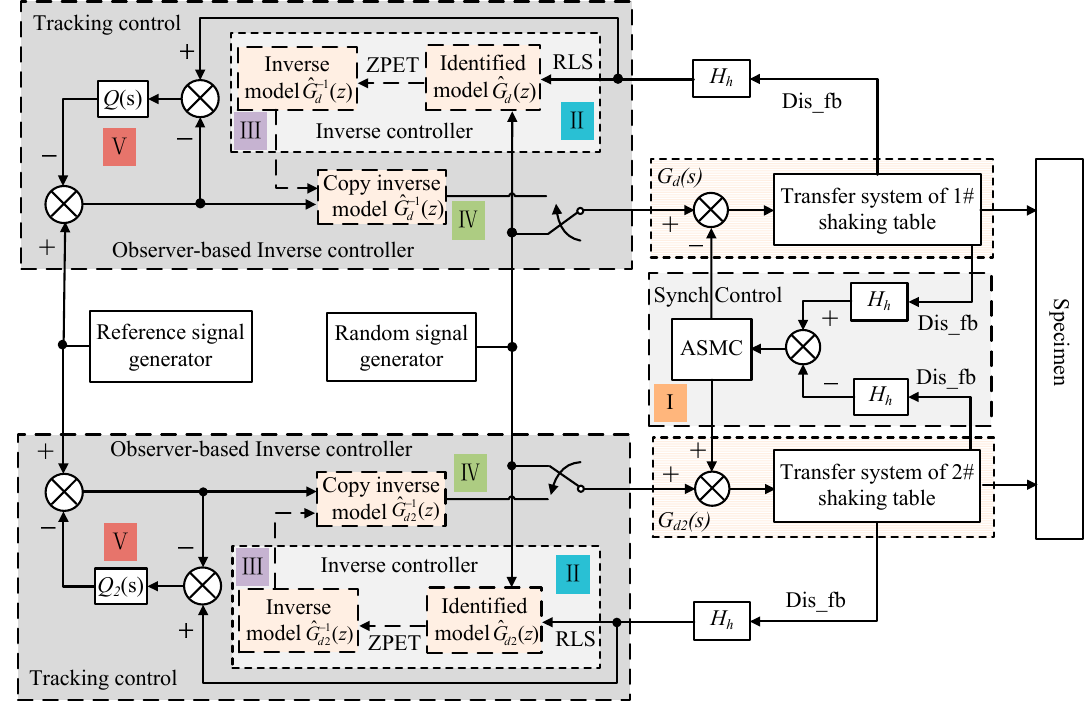
Figure 9. The proposed control scheme for dual ‐ shaking table system.